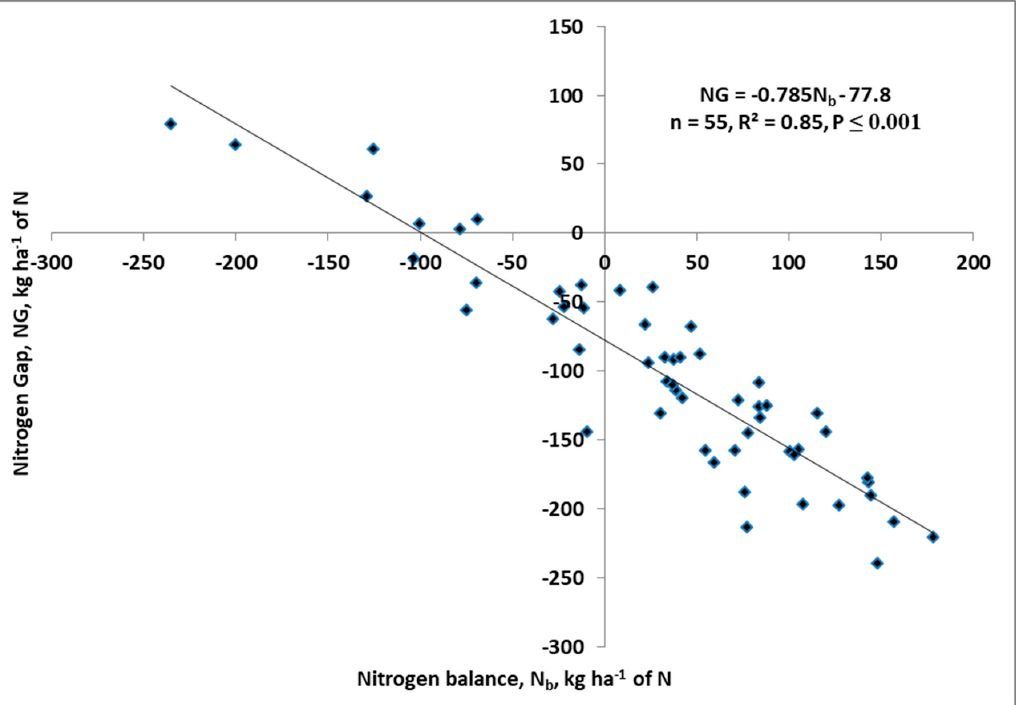
Figure 7. Effect of nitrogen balance in WOSR on the nitrogen gap variability.